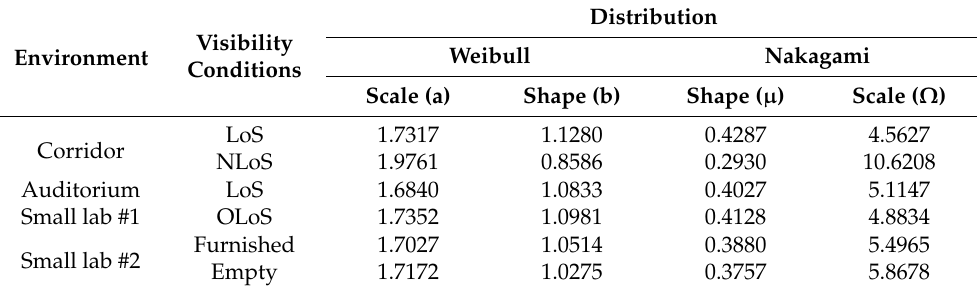
Table 2. Values for the different parameters of statistical distributions at 3 GHz band.